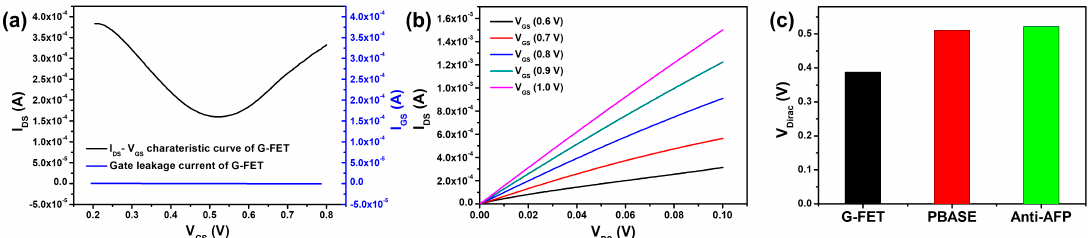
Figure 3. ( a ) I DS -V GS and I GS -V GS transfer characteristic of G-FET; ( b ) I DS -V DS curves of G-FET; ( c ) V Dirac for pristine, PBASE-modified, and anti-AFP-immobilized G-FET.